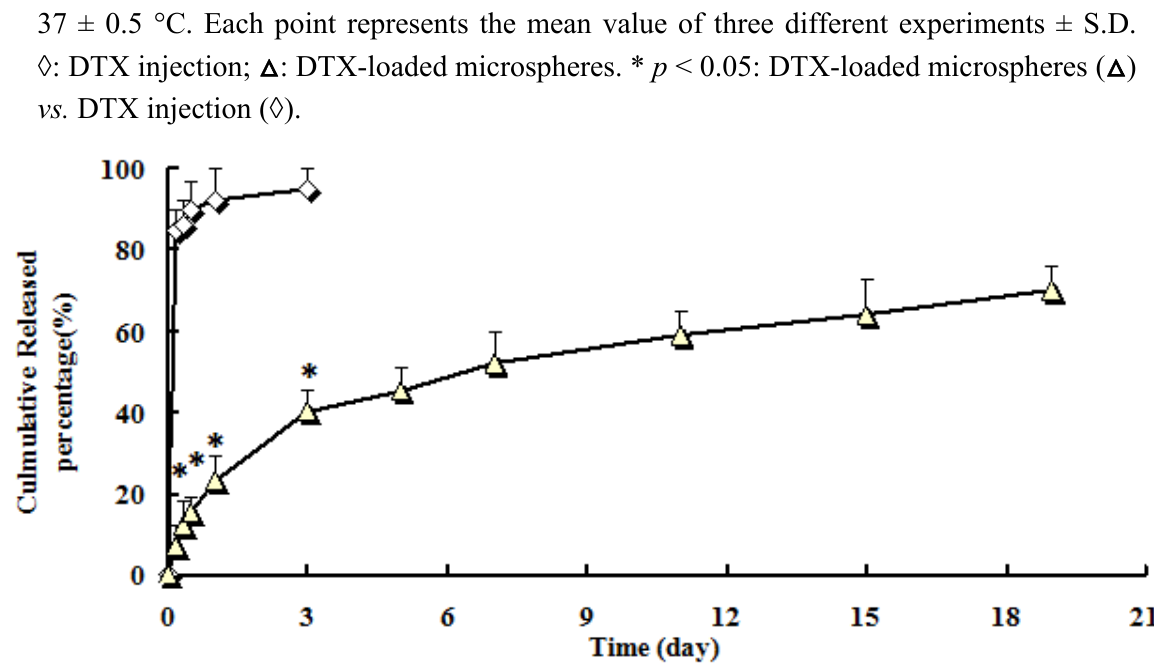
Figure 3. In vitro release profiles of DTX-loaded microspheres from three batches. Release experiments were carried out in PBS (phosphate buffer solution) (pH 7.4), at 37 ± 0.5 °C. Each point represents the mean value of three different experiments ± S.D. ◊ : DTX injection; △ : DTX-loaded microspheres. * p < 0.05: DTX-loaded microspheres ( △ ) vs. DTX injection ( ◊ ).